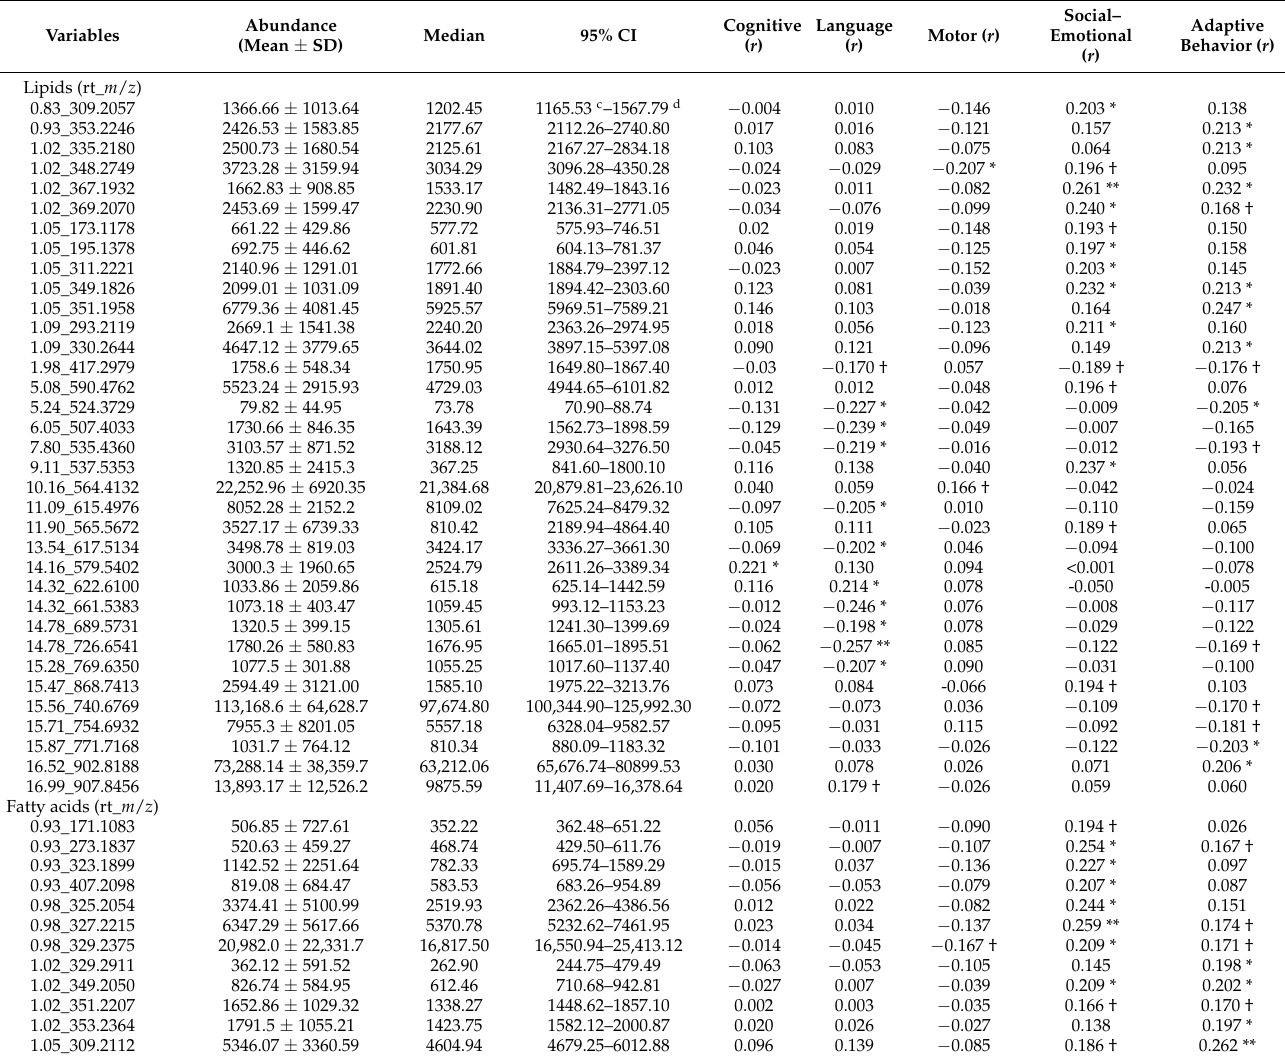
Table 4. Descriptive statistics and Spearman correlation coefficient of significant lipids vs. the five domains of the Bayley-III score (n =